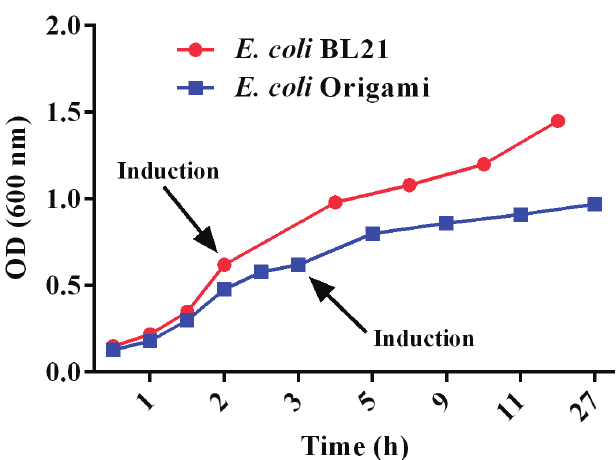
FIGURE 3 - Growth curves of BL21 (DE3) and Origami (DE3) harboring pET-22b (anti-HER2 scFv) plasmid. Recombinant BL21 (DE3) and Origami (DE3) were cultured at 37 °C and the OD6 value was determined at different time 00